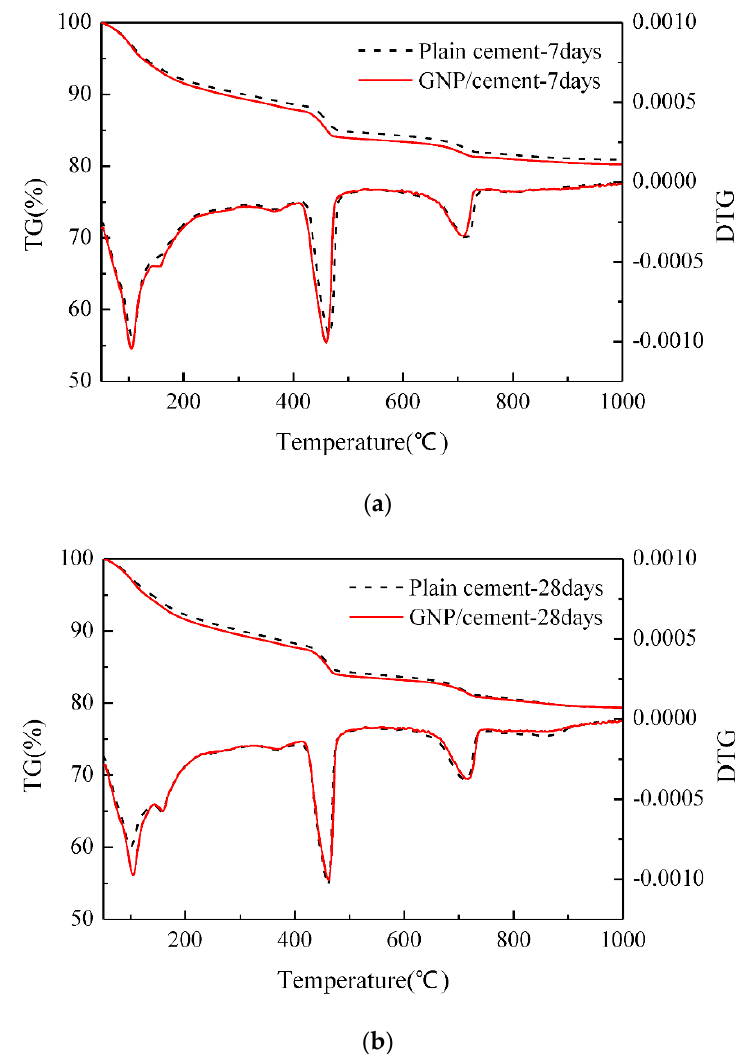
Figure 11. TGA curves of cement composites with and without GNPs ( a ) 7 days, and ( b ) 28 days. Reproduced with permission from [33], MDPI, 2016.